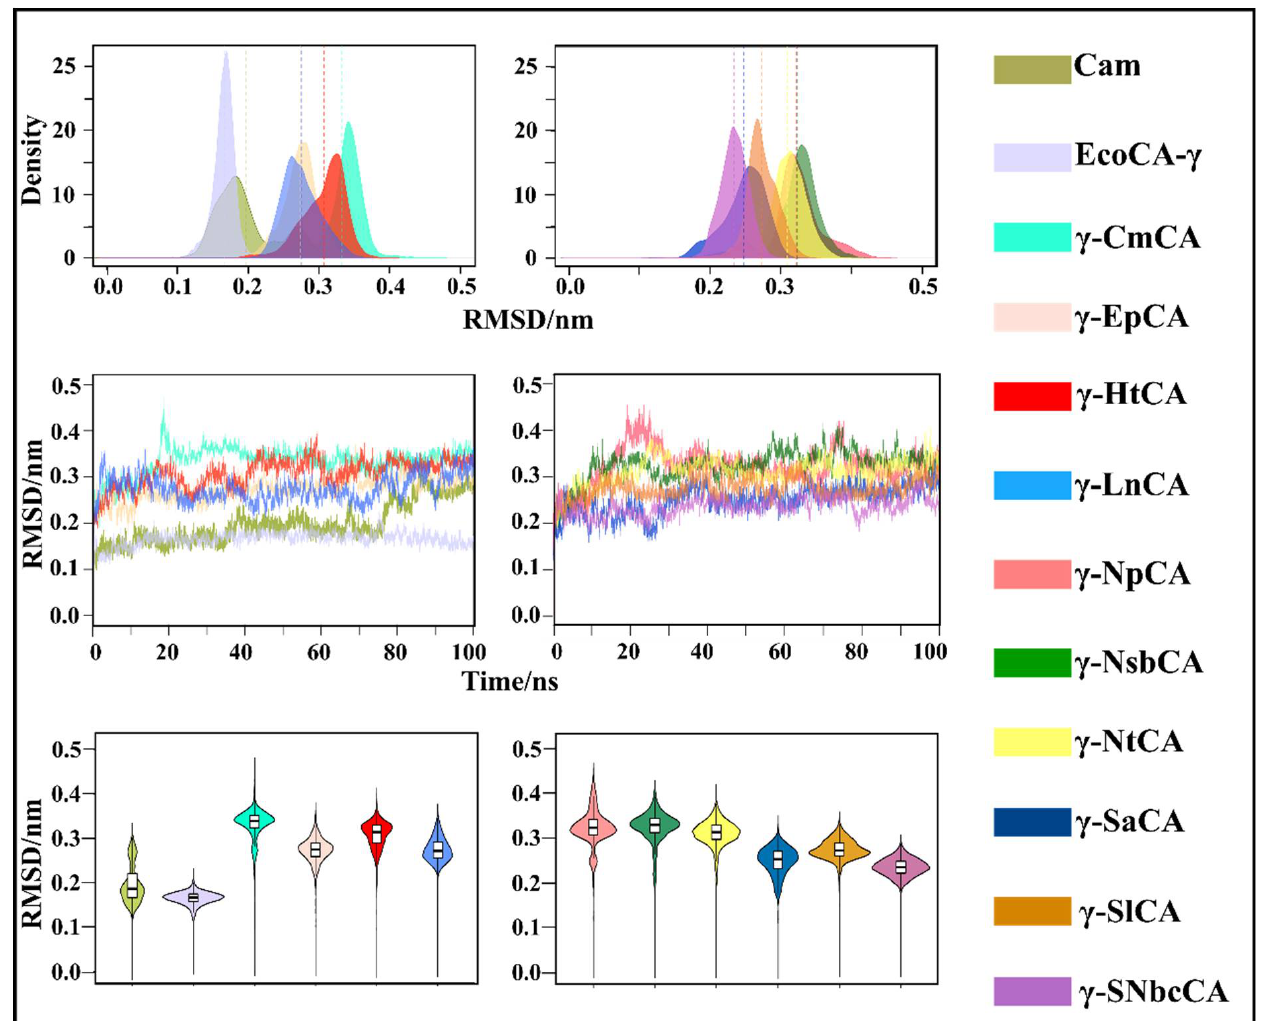
Figure 6. Root mean square deviation (RMSD) kernel density estimation (KDE) plots ( top ), line plots ( middle ), and violin plots ( bottom ) of γ-CAs simulated. The mean RMSD for each γ-CA is depicted as a similar colored line to the KDE plot and as a black line in the violin plots.